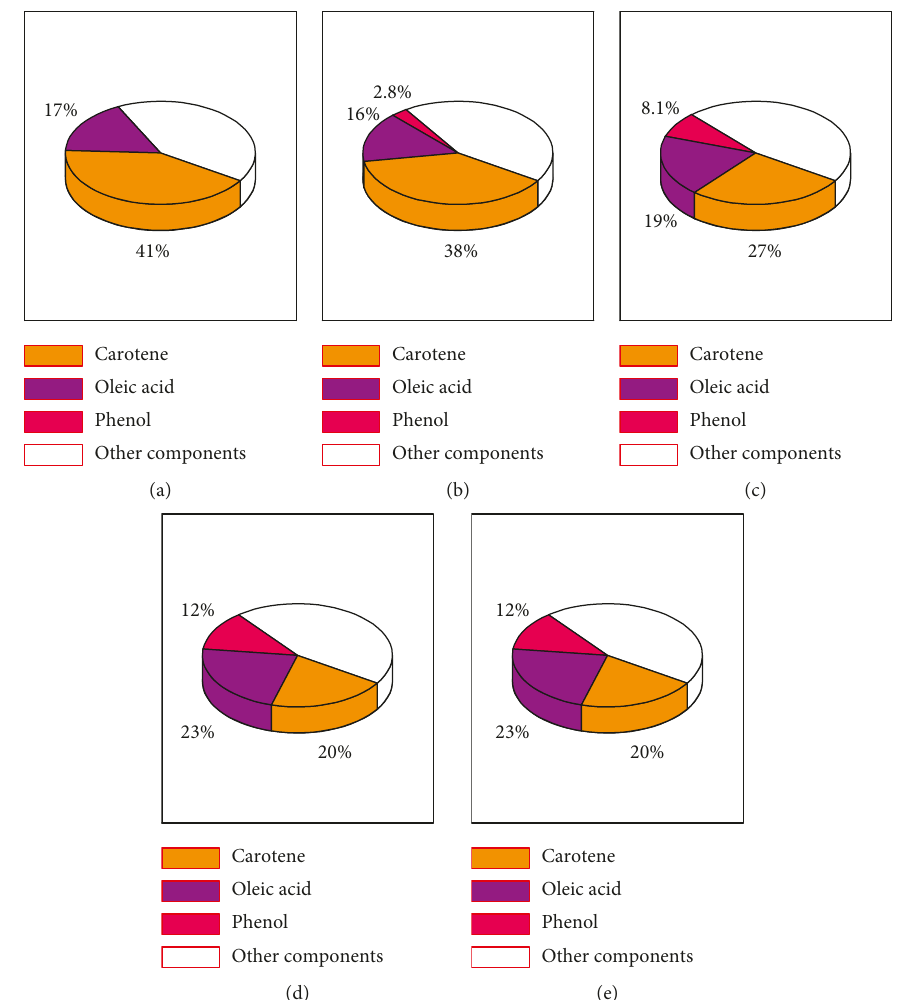
Figure 5: Relative intensities of Raman mode assigned to carotene, oleic acid, and phenol components for noncommercial EVOO samples from different sites (a) Triggiano, (b) Avella, (c) Chiaromonte, (d) Bellona, and (e)